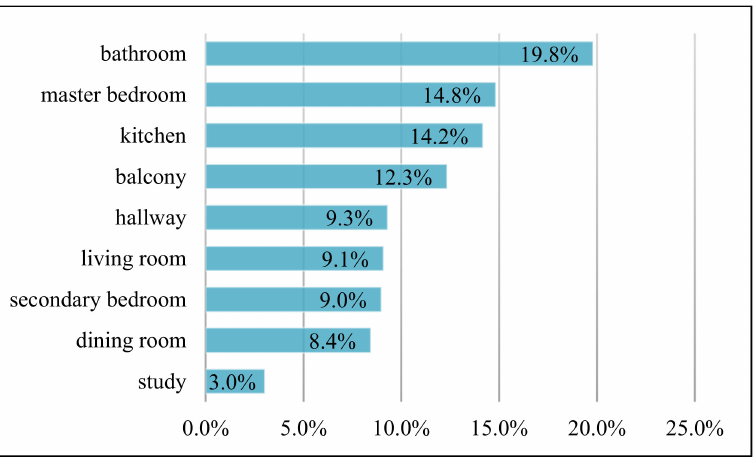
Figure 1. Indoor-space-related issues in cities with low level of COVID-19 pandemic severity. In total, 177 responses were received from cities with a high level of COVID-19 pan- demic severity. These residents provided 627 entries on various indoor space problems. The entries are mainly related to hallways (16.9%), followed by the kitchen (15.6%), bathroom (13.2%), living room (12.4%), dining room (12.0%), secondary bedroom (10.5%),